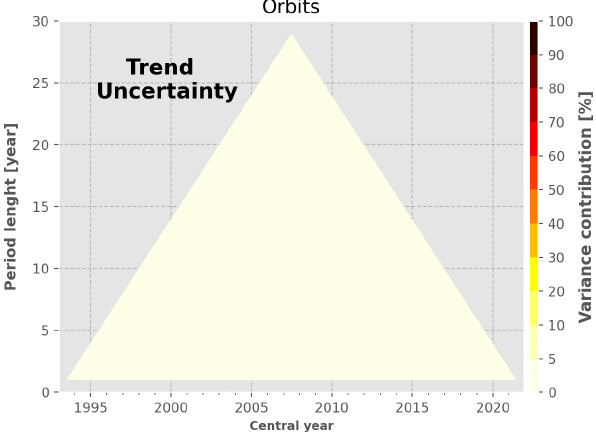
Figure A3. Variance contribution to the GMSL trend variance of the WTC from radiometers.